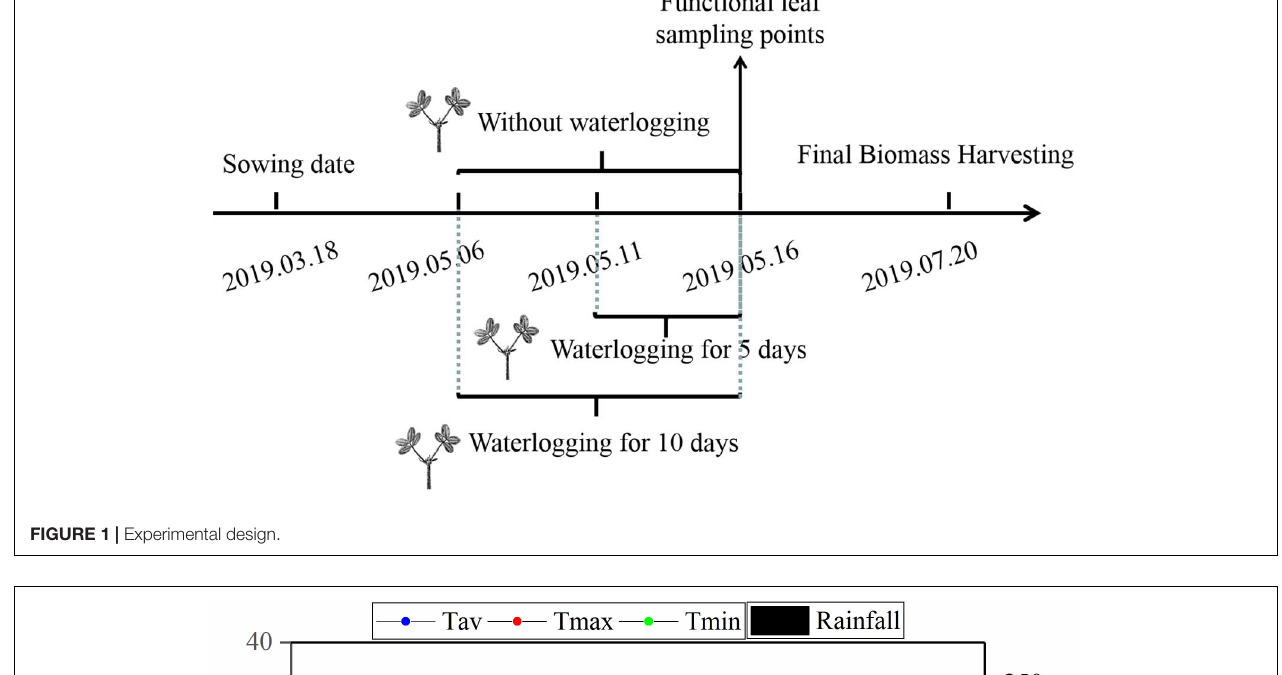
FIGURE 1 | Experimental